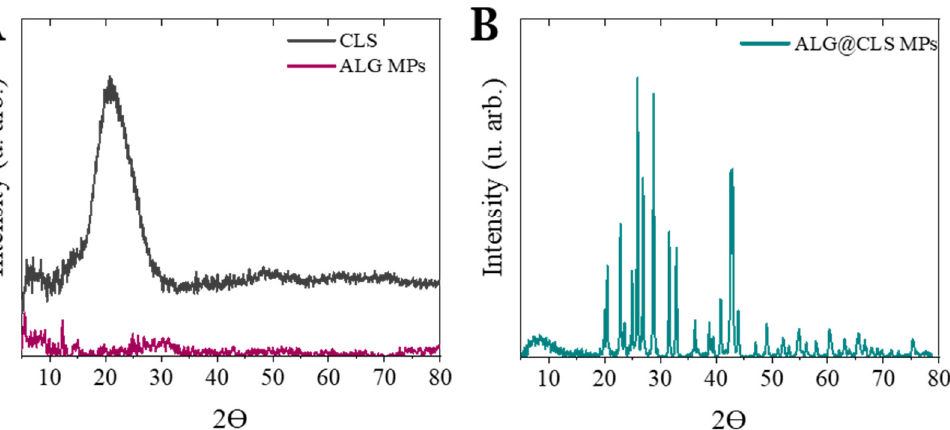
Figure 5. XRD patterns for: ( A ) Alginate microparticles and raw colistin sulfate; ( B ) ALG@CLS MPs.